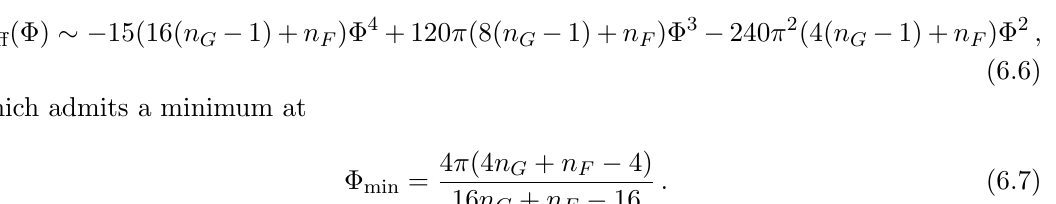
Figure 2 . The e(cid:11)ective potential, V e(cid:11) ((cid:8)), for su (2) with n G = 2 and n F = 0 ; 2 ; 4. for n and n fermions. Then, using eq. (6.4) we obtain, apart from irrelevant additive G F and multiplicative